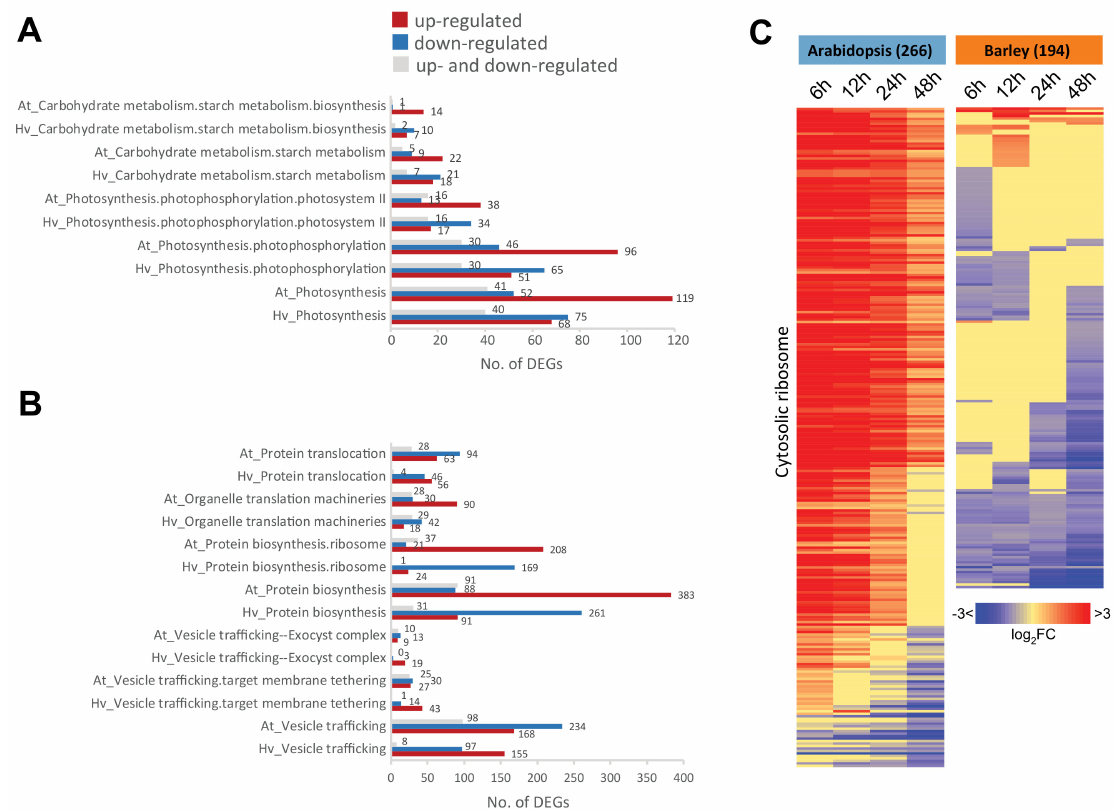
Figure 6. Analysis of distinct expression responses for energy- and protein-related functions during germination in barley and Arabidopsis. The over-represented functional categories in which more genes showed the opposite response to genes in the same category in Arabidopsis were identified, and the total number of DEGs that were upregulated, downregulated, and both up- and downregulated during germination are indicated for each functional category. ( A ) The energy-related functional categories in which more genes showed opposite responses. ( B ) The protein-related functional categories in which more genes showed opposite responses in barley and Arabidopsis. ( C ) Heatmap showing these responses for genes annotated as encoding cytosolic ribosome